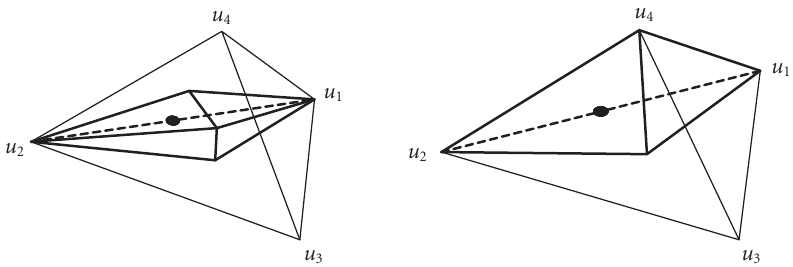
Figure 3.4. Two horoballs centered at ( u 1 + u 2 ) / 2 with π ( g { 3,4 } ) equal to ( u 3 + u 4 ) / 2 on the left and u 4 to the right.